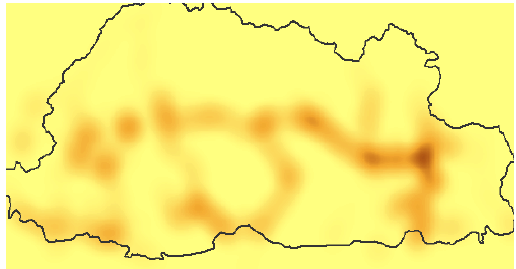
Figure 5. Transportation development index map in Bhutan